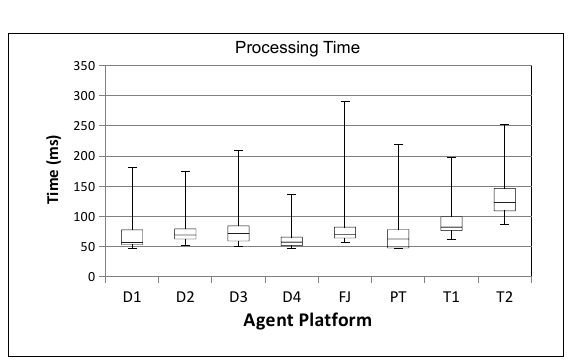
Figure 8. Processing time